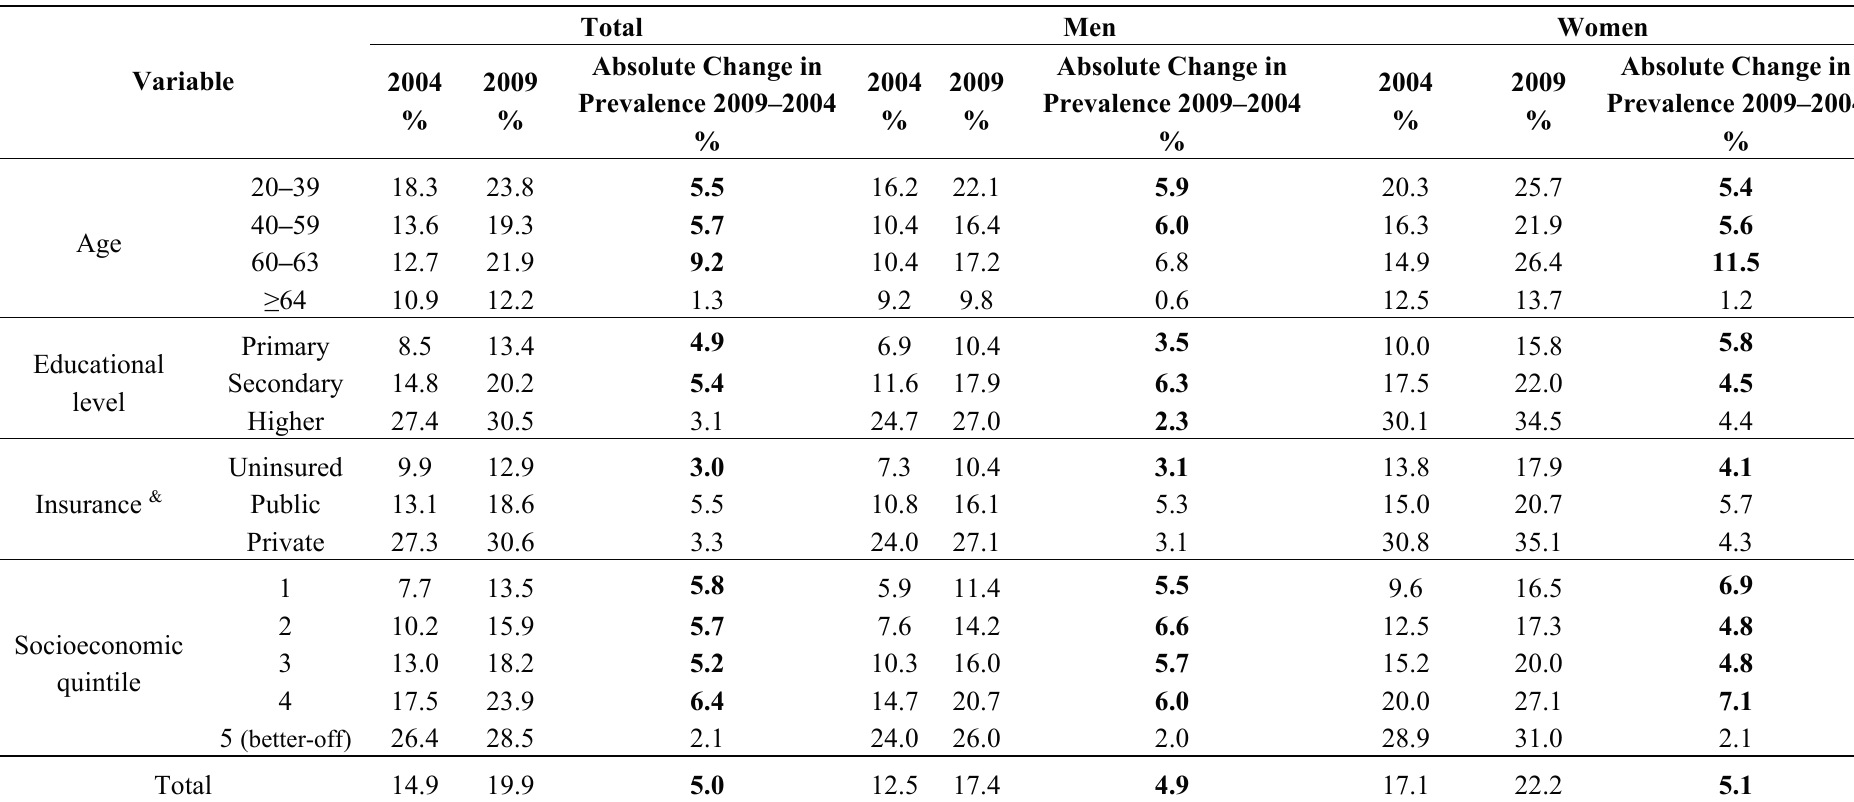
Table 2. Prevalence and absolute changes in the prevalence of having visited a dentist, by socio − demographic variables. People aged ≥ 20 years. “Social Protection Survey”, Chile 2004 and 2009.